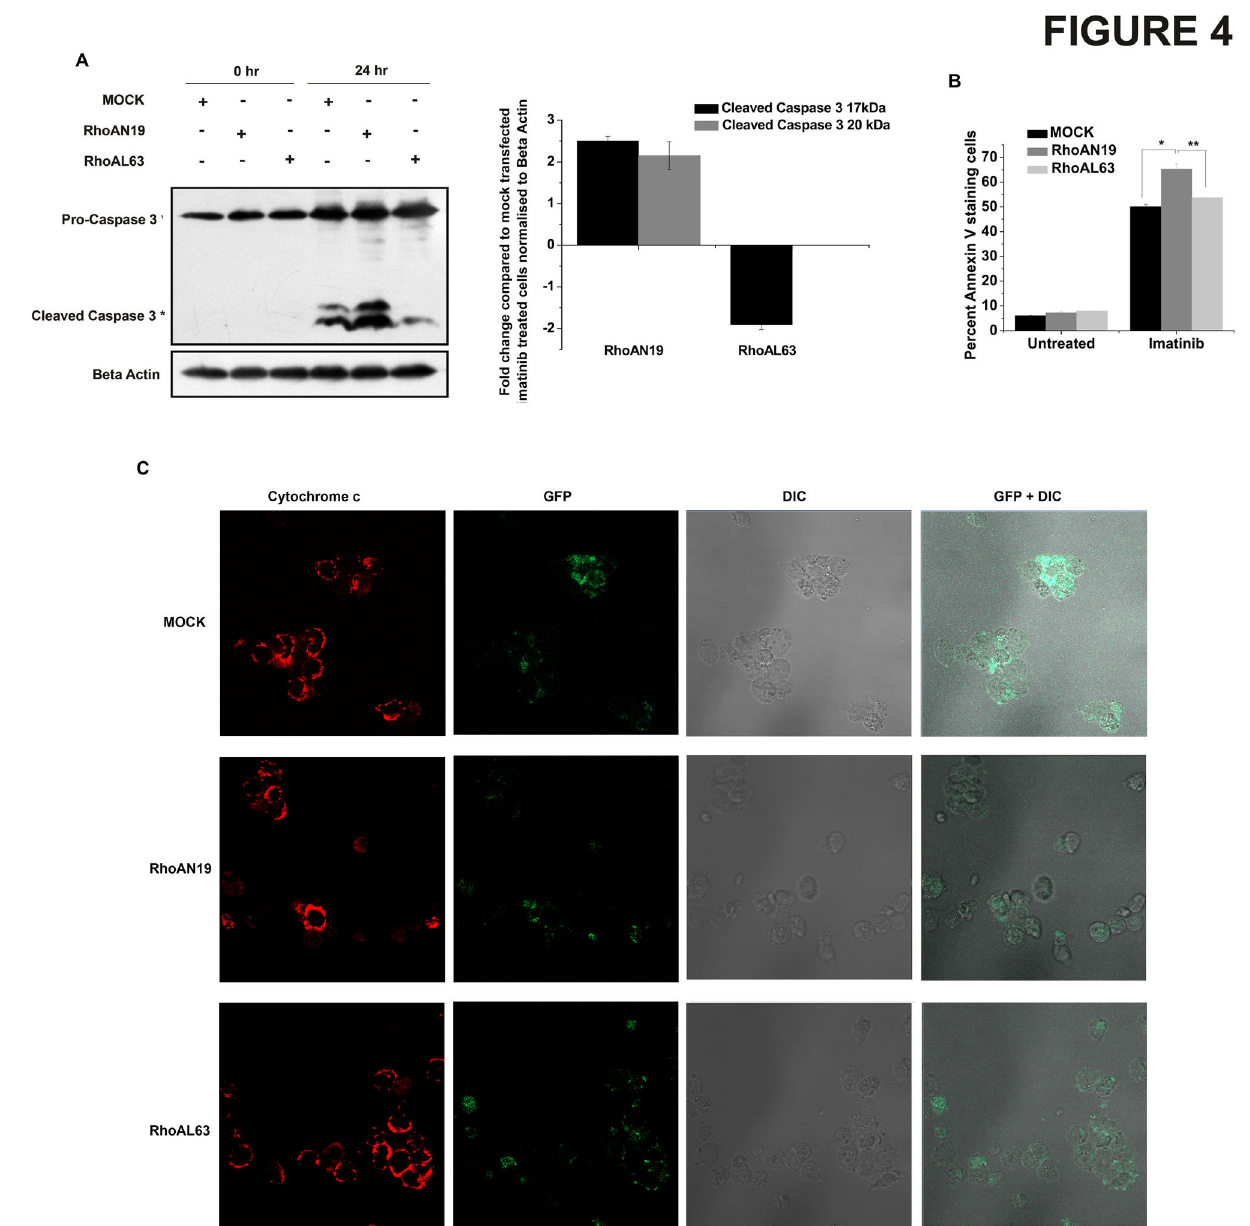
Figure 4. RhoA activity affects cell survival. (A) K562 cells were transfected with MOCK, RhoAN19 or RhoAL63 vectors followed by treatment with 1µM imatinib for the indicated time points in hours. Cell lysates were assessed by western blot for the presence of pro-caspase3 and cleaved active caspase3. Beta actin was used as a loading control. Corresponding densitometric analysis indicates the mean±s.e.m of three independent experiments, (p<0.02). (B) K562 cells were transfected with MOCK, RhoAN19 or RhoAL63 vectors followed by treatment with/without 1µM imatinib. Cell survival was assessed by Annexin V staining. The plot shows the percent Annexin V positive staining population in three independent experiments (*p<0.005, **p<0.008) (C) K562 cells were transfected with GFP tagged MOCK, RhoAN19 or RhoAL63 vectors followed by treatment with/without 1µM imatinib for 24 hr. Cells were stained with anti cytochrome c antibody (red) and observed under the confocal microscope. The panel shows cytochrome c staining (red), GFP (green), differential interference contrast (DIC) image and a merged image of GFP and DIC. Release of cytochrome c from mitochondria gives a diffused cytochrome c staining as against the punctate staining pattern observed in cells with intact mitochondrial membrane permeability.